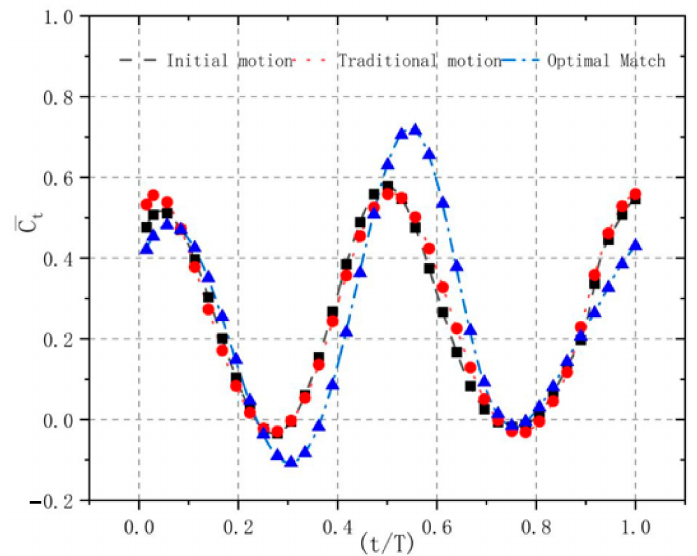
Figure 16. Variation of thrust coefficient in one cycle before and after optimal